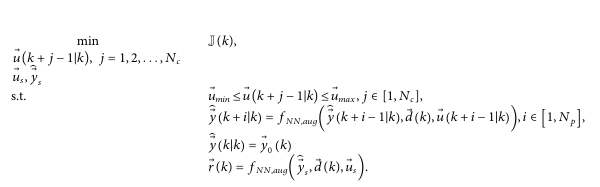
FIGURE 6 | Comparison between the physiological outputs predicted from the modi fi ed in silico physiological model (IP, shown in blue), the in silico physiological model (PM, shown in black) and LSTM model (shown in red) in response to the vagus nerve stimulation (VNS) for 200 simulated cardiac cycles. (A) shows the heart rate (HR, bpm) and (B) shows the mean arterial blood pressure (MAP, mmHg). For cycles 1 – 50 (light green), location 1 was active with a pulse width of 0.36 ms and pulse frequency of 31 Hz. For cycles 51 – 100 (light blue), location 2 was active with a pulse width 0.19 ms and a pulse frequency 17 Hz. For cycles 101 – 150 (yellow), location 3 was active with a pulse width of 0.42 ms and a pulse frequency of 47 Hz. The last 50 cycles did not have any locations